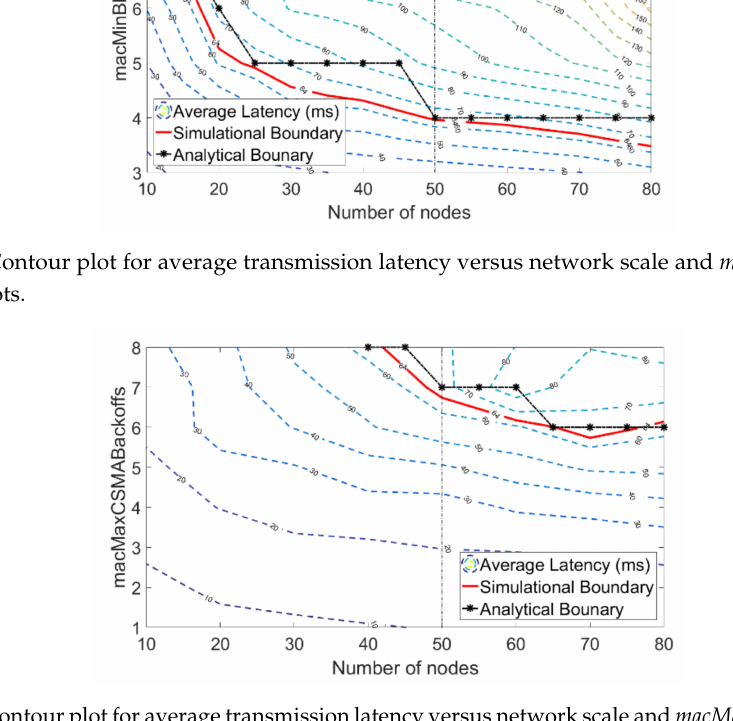
Figure 9. Contour plot for average transmission latency versus network scale and macMaxCSMABacko ff s given PI = 200